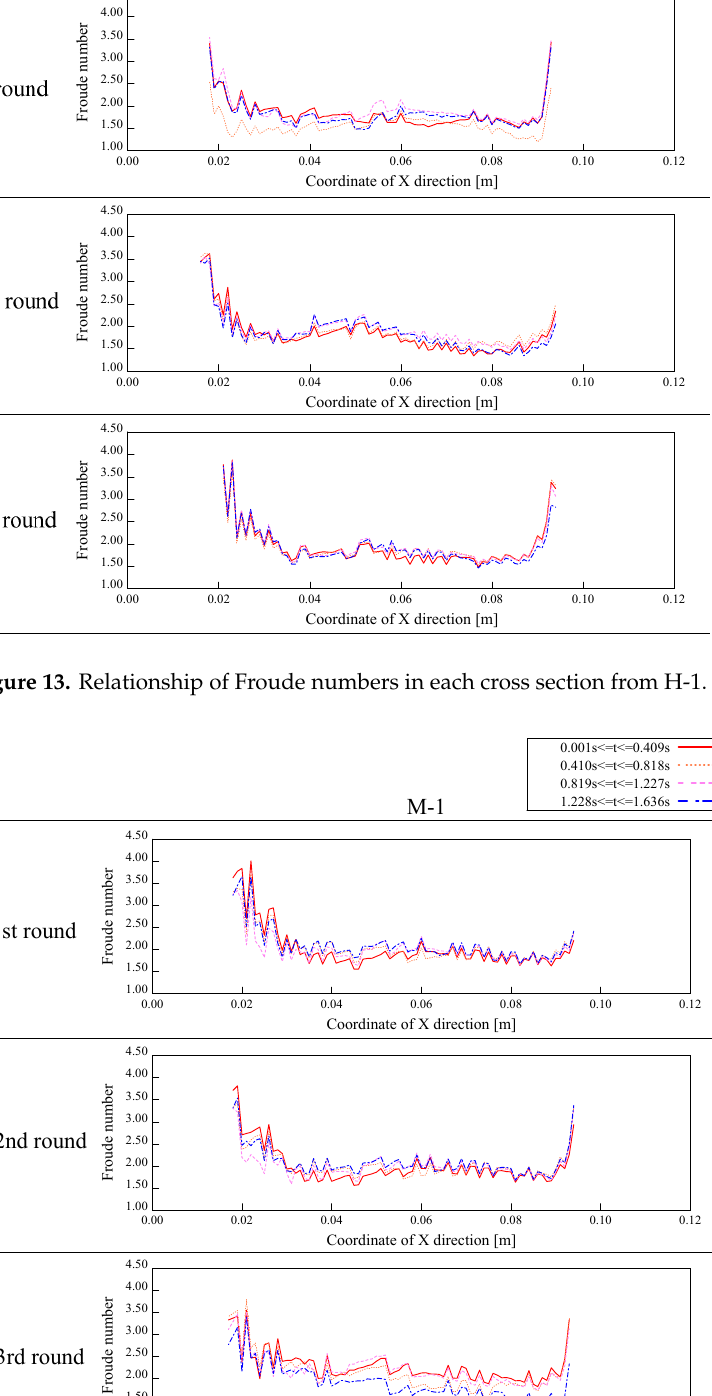
Figure 14. Relationship of Froude numbers in each cross section from M-1.